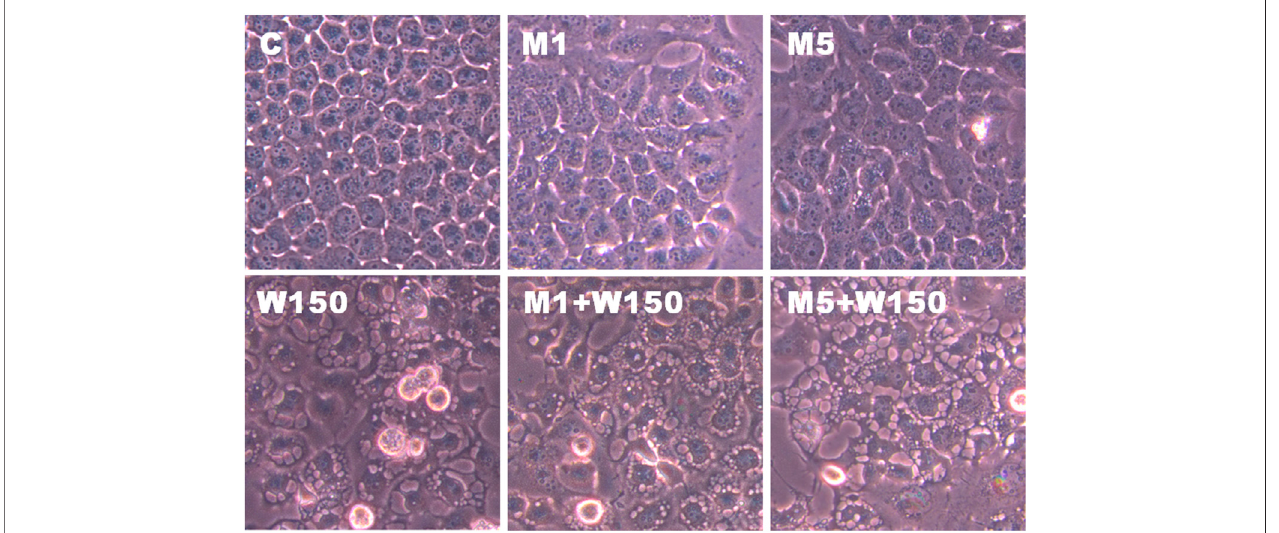
FIGURE 10 | The effects of 3-MA on WGM extracts-induced membrane-enclosed vacuoles of Hep3B cells. Cells were pretreated with 1 or 5 mM 3-MA (M1 and M5)for1 handthentreatedwith0.1%DMSO(C)or150 μ g/mlWGMextracts(W150)for24 h.Aftertreatment,thecellswereimmediatelyphotographed(150X).Results are representative of three independent experiments.